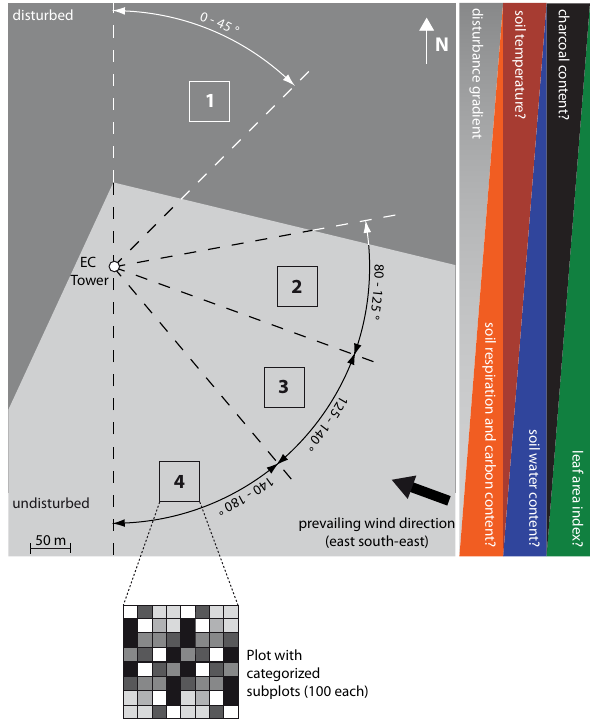
Fig. 1. Scheme of the site and experimental setup in Mongu (Zam- bia). The dark grey area represents the disturbed area driven by de- forestation, burning and grazing. The light grey area represents the north western corner of Kataba forest reserve, established in 1973. The measurement plots, divided into subplots of different ground cover, were established along a disturbance gradient from North to South, with plot 1 being highly disturbed, 2 and 3 being slightly disturbed (edge effects) and 4 undisturbed in the core area of the forest reserve. The prevailing wind direction was east-southeast. All plots were located within the 50% fetch of the eddy covariance tower. Wind sectors in the direction of the inventory plots, used for the comparison of eddy covariance measurements to chamber measurements are shown. Coloured triangles are given to visualize hypothesized trends of the most important abiotic and biotic param-